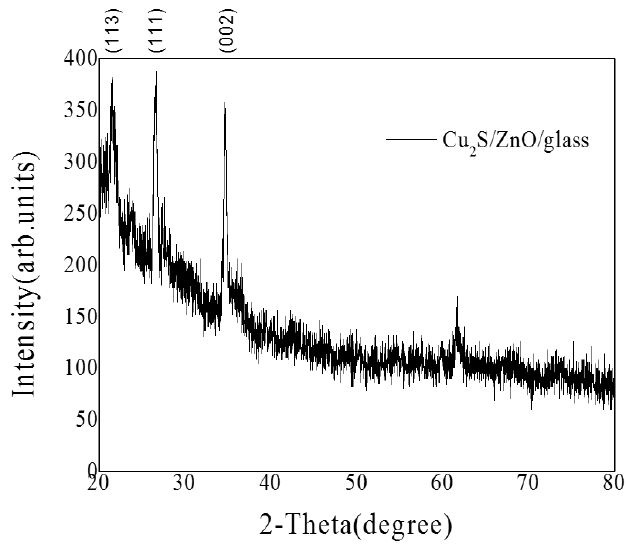
Figure 14. The XRD patterns of Cu 2 S/ZnO/glass films.